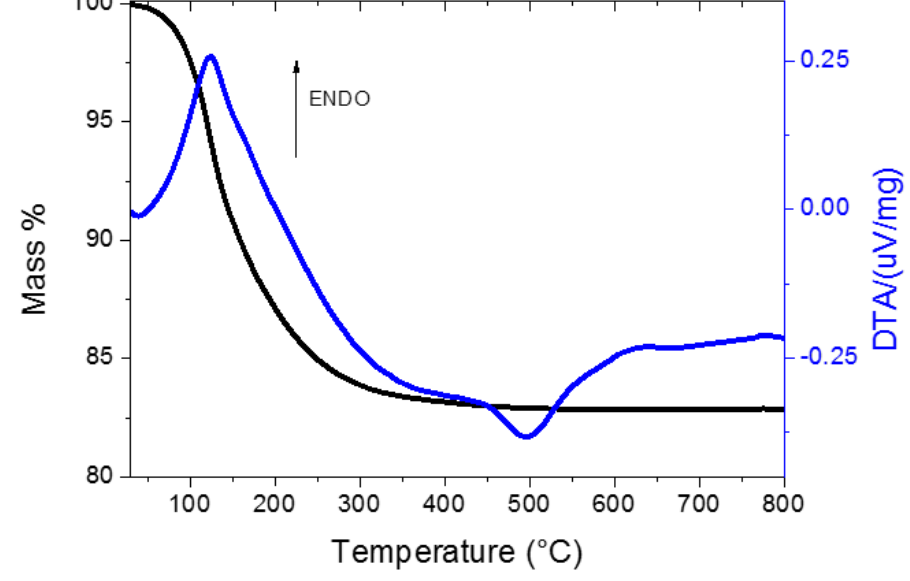
Figure 2. Uncalcined titania TG/DTA analysis.